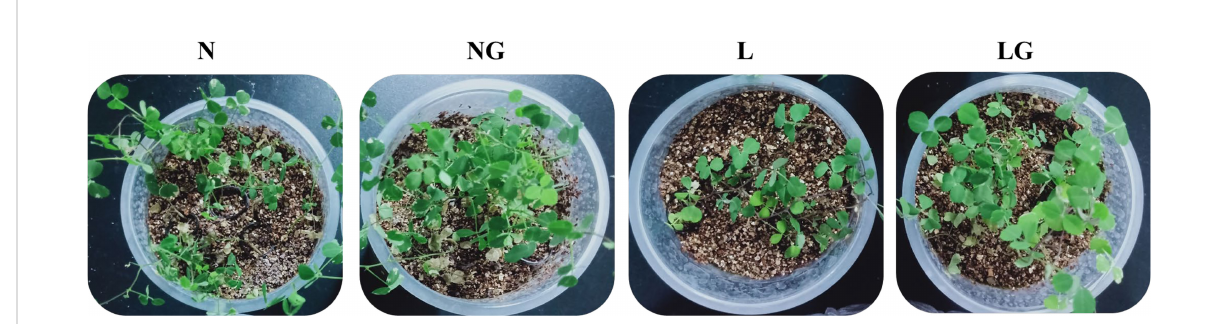
FIGURE 2 Effect of GABA spraying on the phenotypic characteristics of M. ruthenica seedlings under normal- and low-temperature treatments. N, leaves sprayed with distilled water + normal temperature (25°C/20°C); NG, leaves sprayed with 15 mmol/l GABA + normal temperature; L, leaves sprayed with distilled water + low-temperature stress (2 h at 7°C; 6 h at 15°C; 4 h at 12°C; 2 h at 7°C; 10 h at 3°C); LG, leaves sprayed with 15 mmol/l GABA + low-temperature